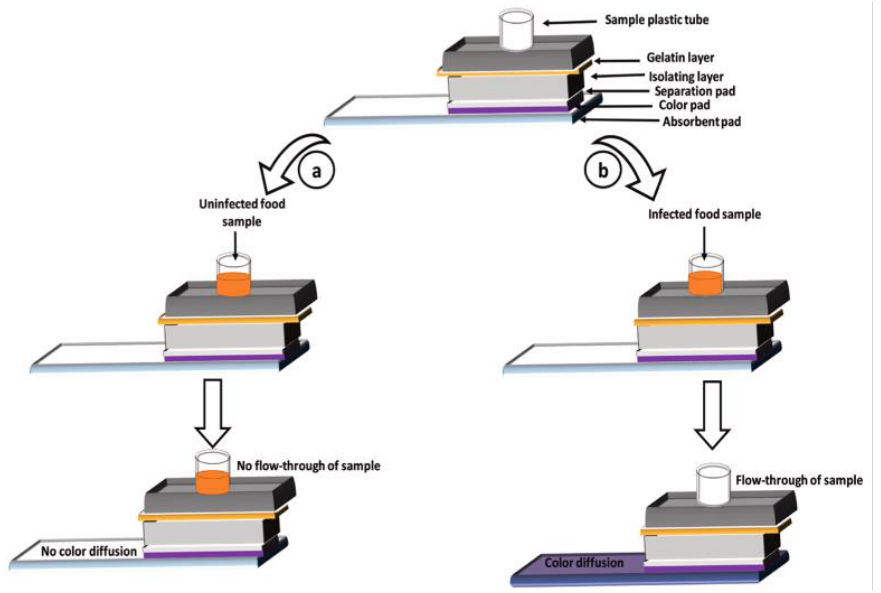
Figure 4. Schematic presentation of the gelatin-based assay for the detection of B. cereus [94] (copyright (2022) Elsevier B.V.